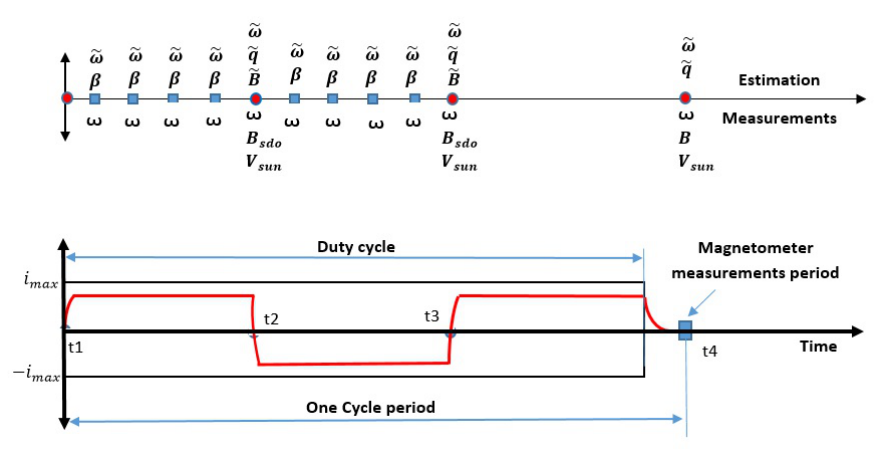
Figure 2. The proposed magnetic rod